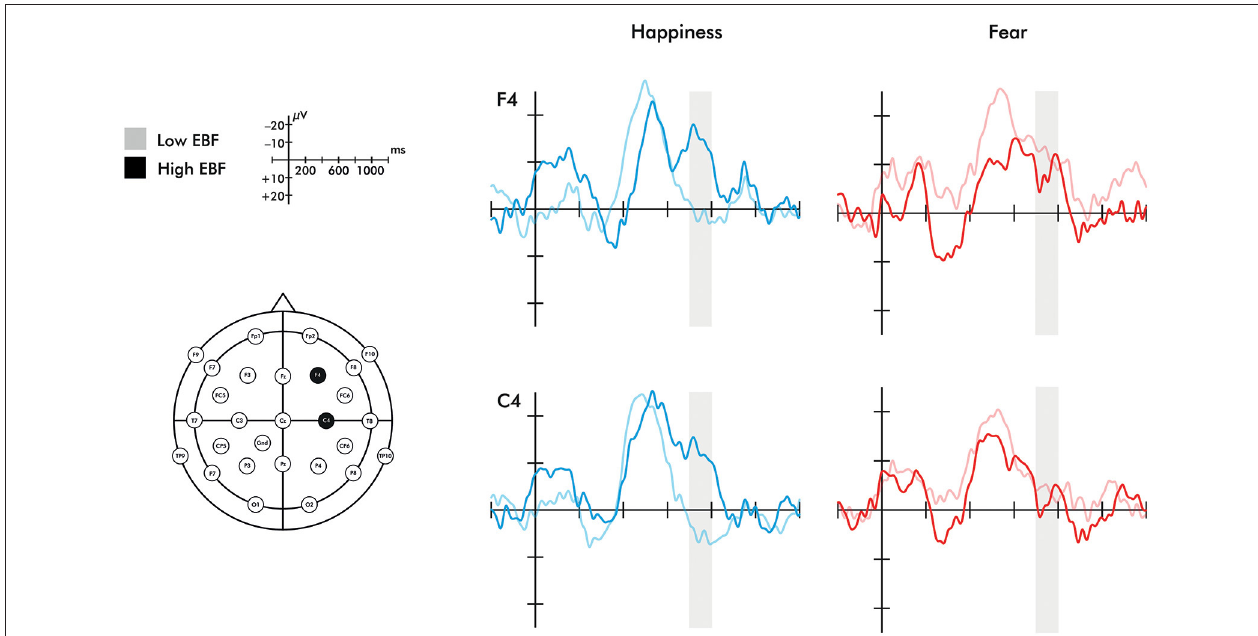
FIGURE 2 | Event-related potentials for the F4 and C4 electrodes in response to happiness and fear . Region shaded in gray represents the time window of the Nc analyzed. Please note that the time windows of 0–200 ms and 400–600 ms did not differ significantly between groups for either electrode.